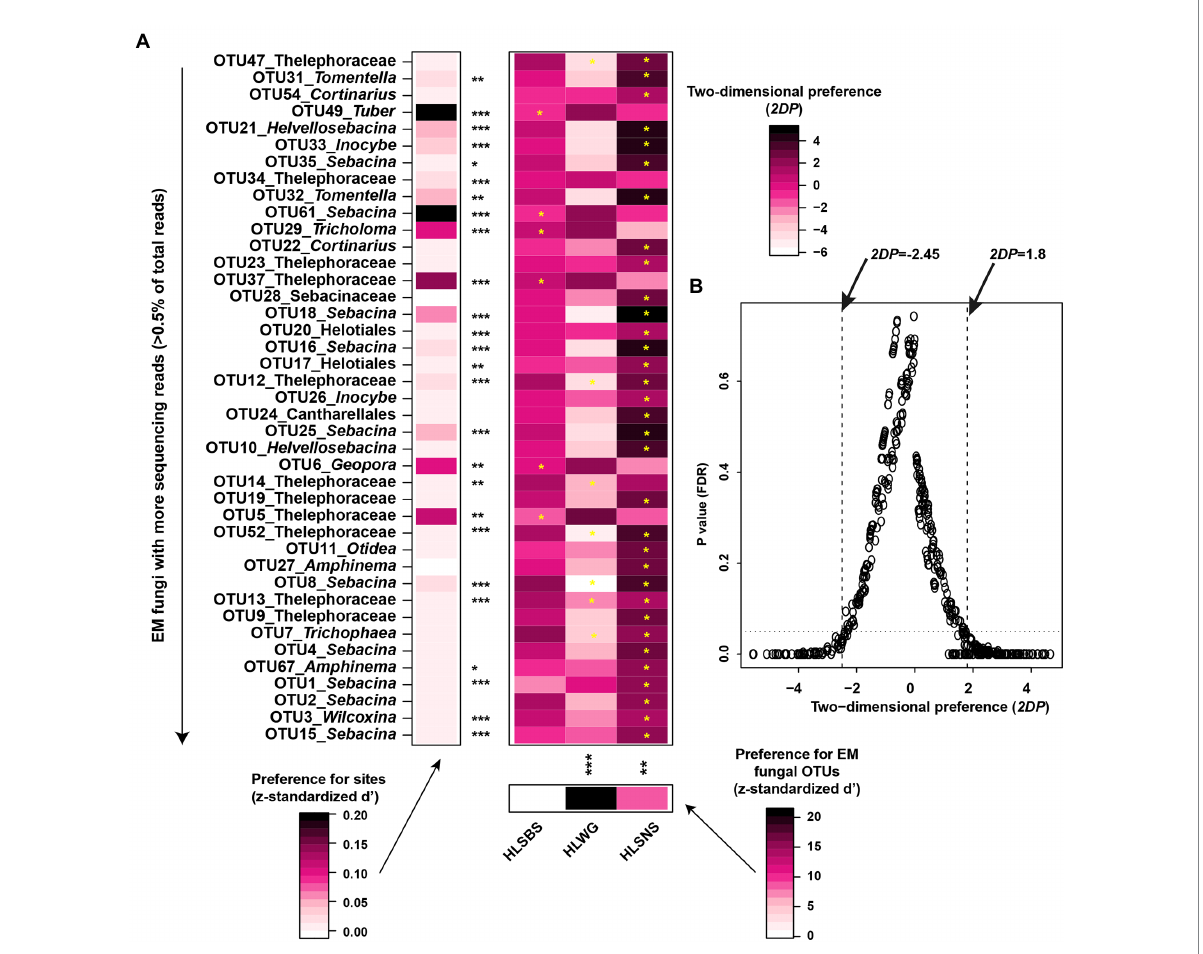
FIGURE 4 Preferences of site-fungus associations. (A) Standardized d’ estimates of preferences for ectomycorrhizal (EM) fungal operational taxonomic units (OTUs) for sites (columns). Similarly, the standardized d’ estimate of preferences for sites is indicated for each of the observed fungal OTUs (row). Each cell in the matrix indicates a two-dimensional preference (2DP) estimate and evaluates to what extent each pair of each site–fungus association was observed (counts) more or less frequently than would be expected by chance. (B) Relationship between 2DP and FDR adjusted p values, 2DP values larger than 1.80 represented strong preferences. The p value obtained from the preference analysis was generated by the one- tail method and adjusted based on the false discovery rate (FDR). Significance: * p < 0.05, ** p < 0.01, and *** p < 0.001. HLSBS, HeLanShan-BeiSi; HLWG, HaLaWuGo; and HLSNS,